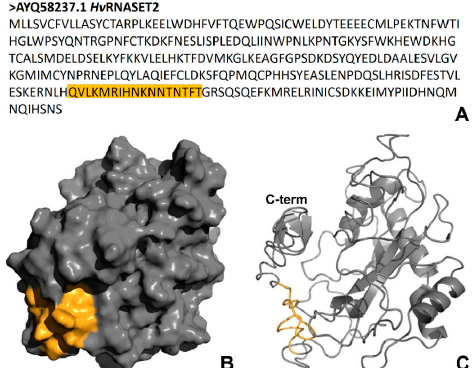
Figure 2. Antimicrobial peptide identification. ( A ) The HvRNASET2 primary sequence was analyzed with the AMPA software [13] in order to identify possible antimicrobial peptides, and a specific sequence of amino acids (QVLKMRIHNKNNTNTFT), underscored in orange, was detected in the C-terminal region. ( B , C ) Three-dimensional representations of the detected peptide are displayed in orange. Of note, it is arranged on the outer surface ( B ) and in the C-terminal region (NQMNQIHSNS) ( C ) of the enzyme.